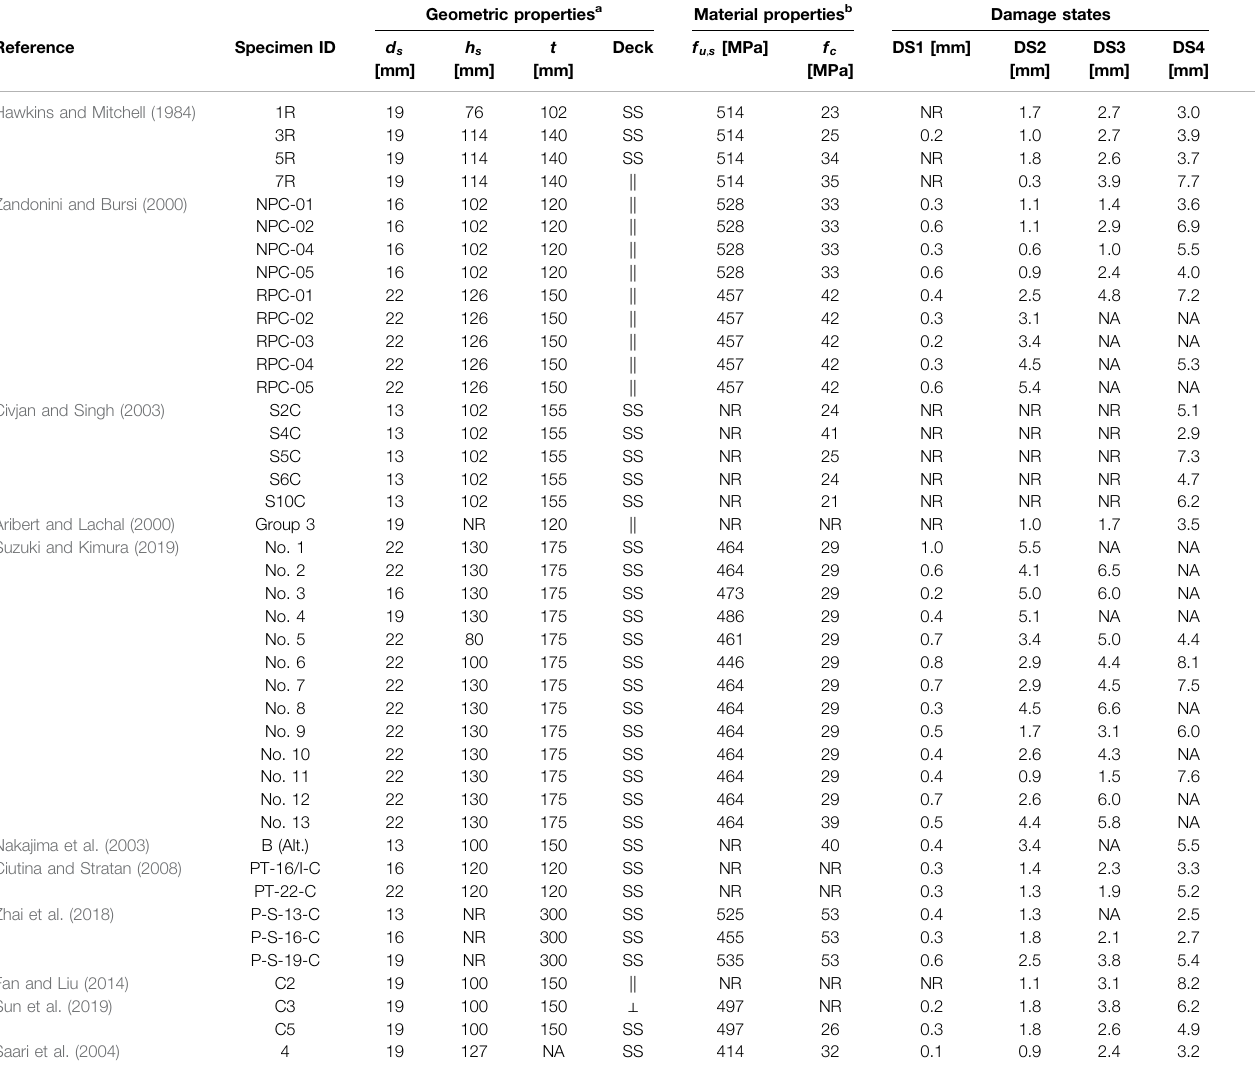
TABLE 1 | Dataset of cyclic push-out